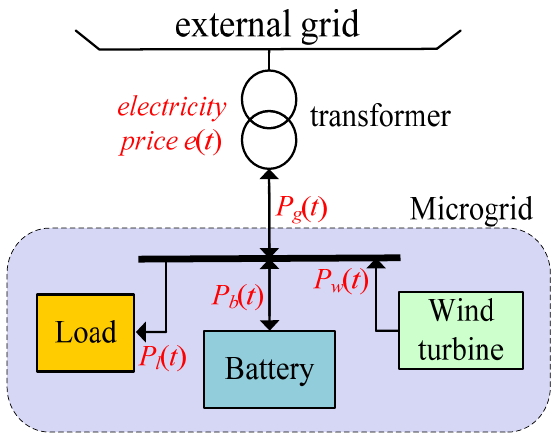
Figure 2. A simplified model of a